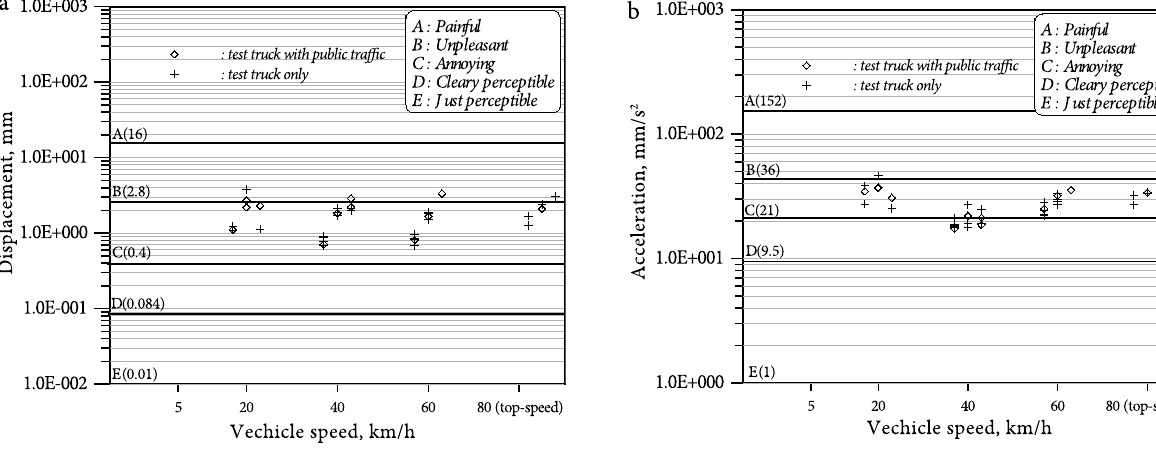
Fig. 9. Max amplitude from dynamic loading test (out-case): a – displacement; b – acceleration